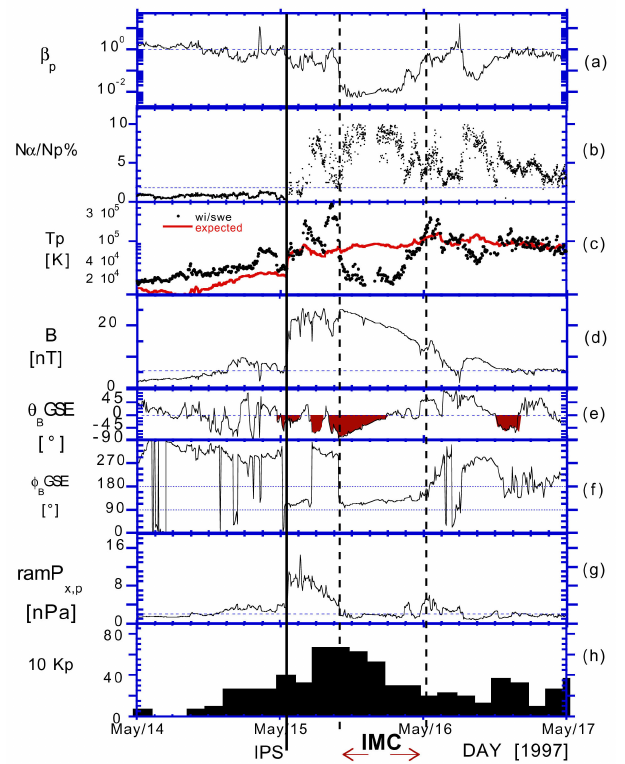
Fig. 2. Ejecta signatures used in this work (for Event 9) in panel: (a) proton plasma β p ; (b) solar wind He ++ to H + ratio; (c) observed and expected proton temperature Tp ; (d) intensity of the interplan- etary magnetic field; (e) and (f) latitude and longitude orientation of the interplanetary magnetic field in GSE coordinates; (g) solar wind plasma ram pressure. Mid-latitude Earth’s geomagnetic re- sponse index K p is given in panel (h) . The dash-lines in panels (a), (b), (d), and (g) indicate the near ecliptic, approximate long-term solar wind mean values at 1AU.